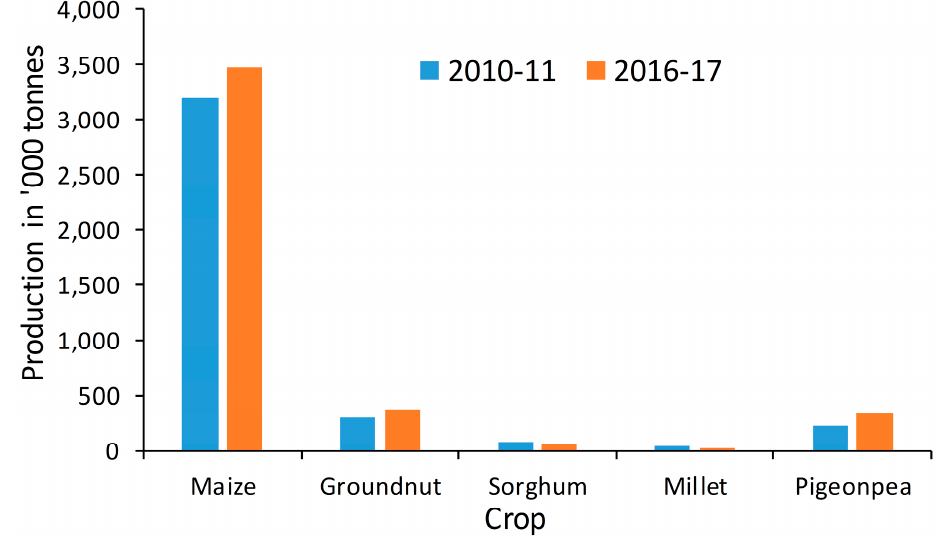
Figure 8. Production of important crops in Malawi Figure 9. Production of important crops in Malawi [40].